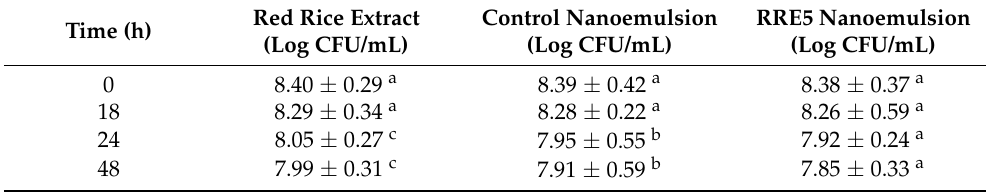
Table 1. Time-kill Study of red rice extract, control, and RRE5 nanoemulsion against Escherichia coli . Red Rice Extract Time (h) (Log CFU/mL) (Log CFU/mL)